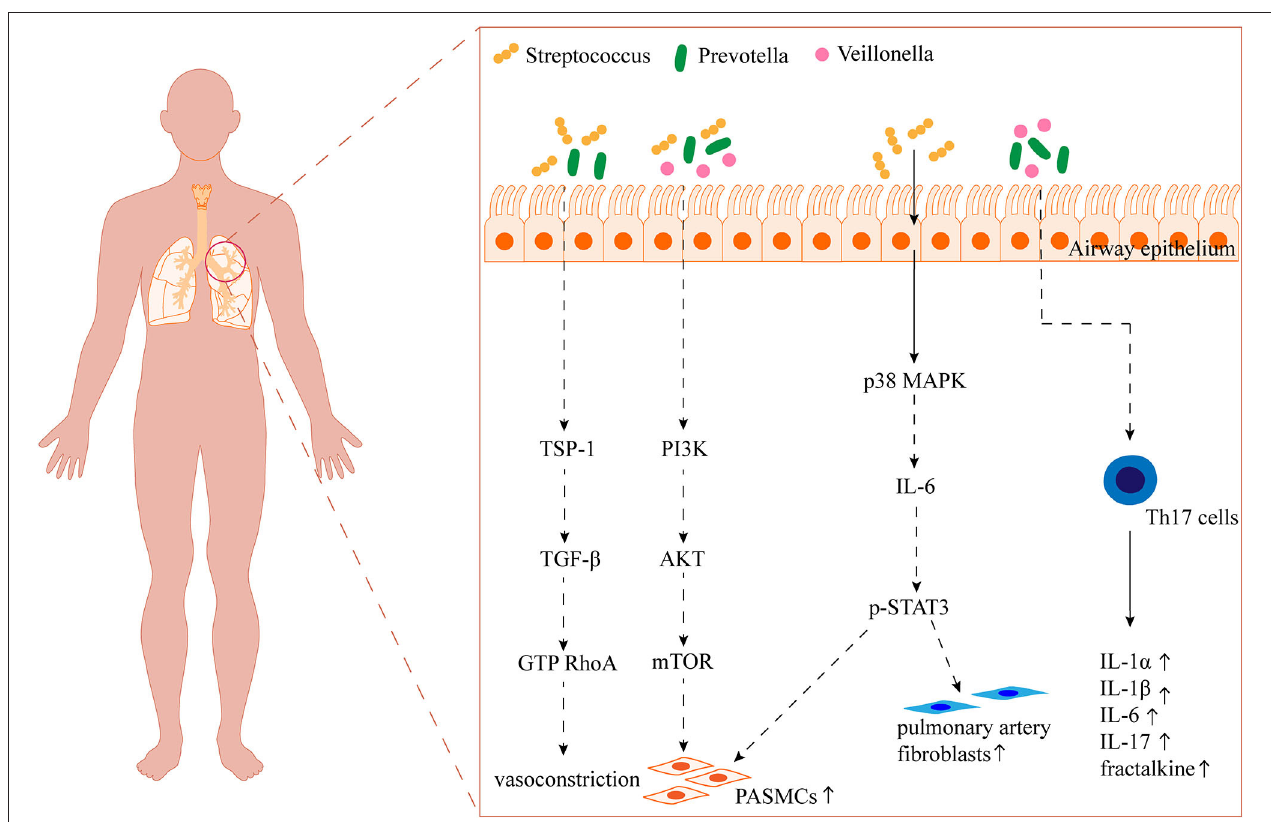
FIGURE 2 | Overview of the potential impact of the airway microbiota on PAH. TSP-1: thrombospondin 1; TGF- β : transforming growth factor- β ; RhoA: the small GTP-binding protein; PI3K: phosphatidylinositol 3-kinase; AKT: protein kinase B; mTOR: mammalian target of rapamycin; MAPK: mitogen-activated protein kinase; STAT3: transcription